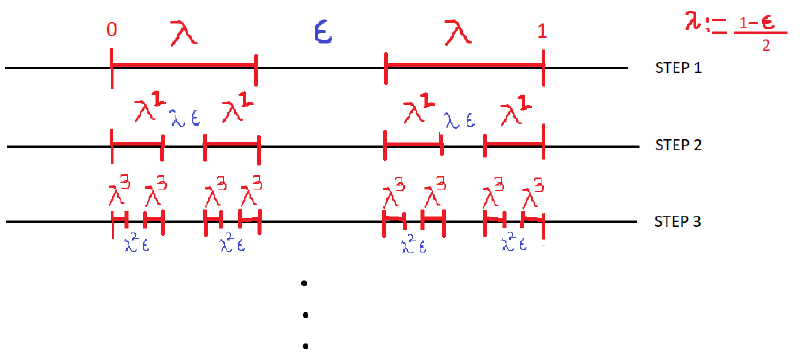
Figure 3. The middle ε Cantor